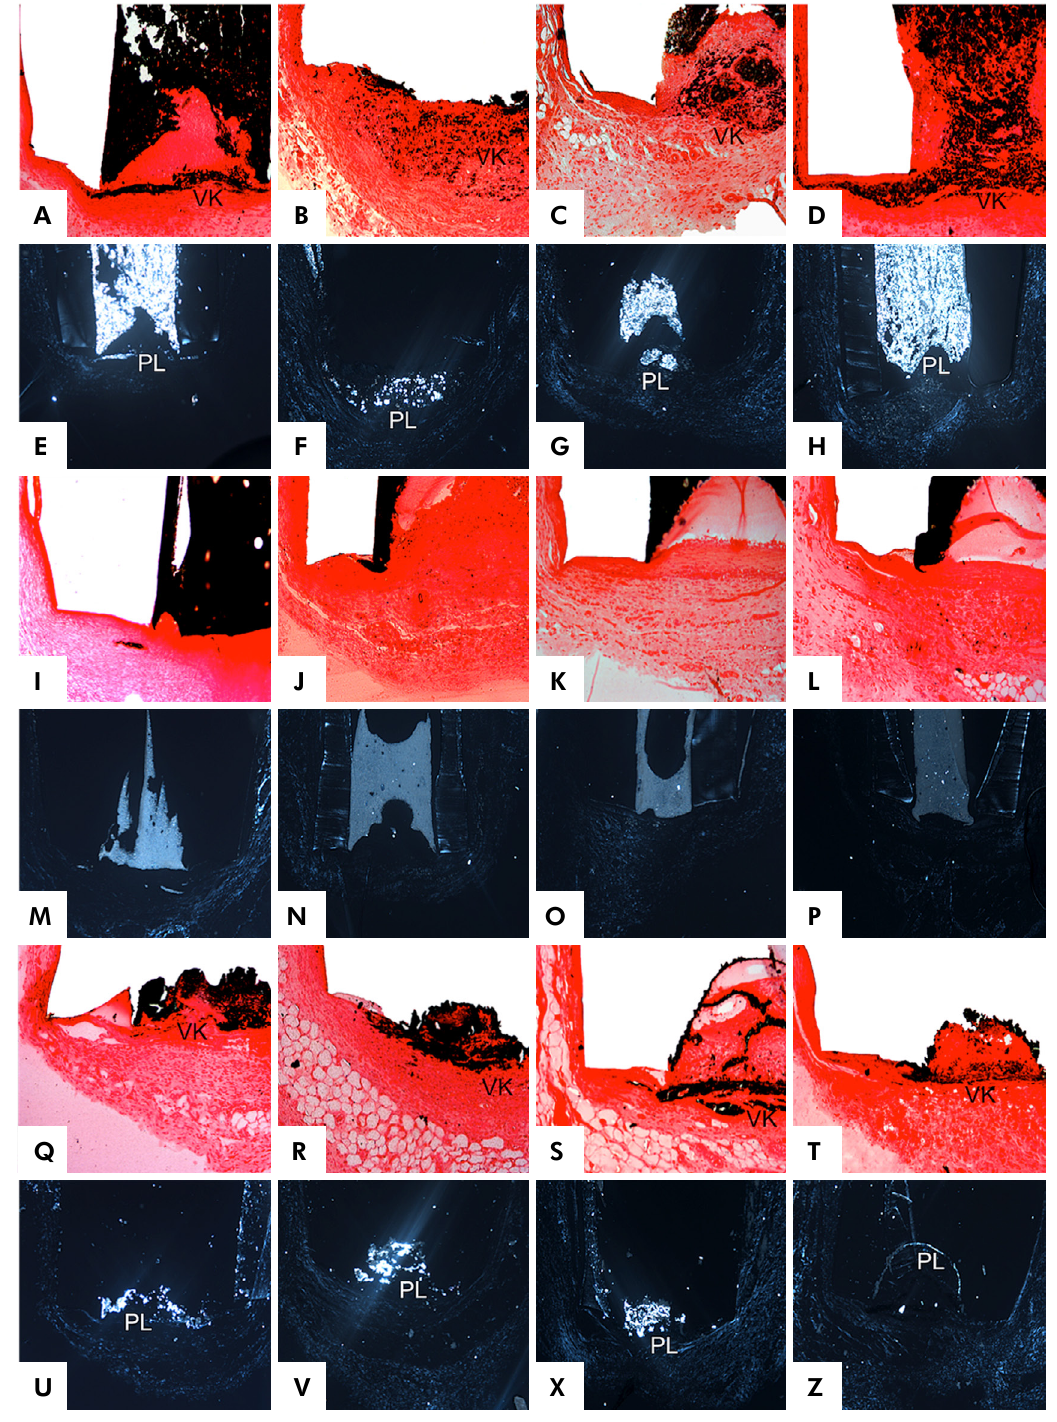
Figure 2. Biomineralization in the experimental groups. Sealapex: (A–D) the presence of dystrophic calcification on the tube opening (days 7, 15, 30, and 60; Von Kossa, 10 ×) and (E–H) the presence of birefringent structures under polarized light (days 7, 15, 30, and 60, polarized light 5 ×); Acroseal: (I–L) the absence of dystrophic calcification on the tube opening (days 7, 15, 30, and 60; Von Kossa, 10×) and (M–P) the absence of birefringent structures under polarized light (days 7, 15, 30, and 60; polarized light, 5 ×); and Smartpaste Bio: (Q–T) the presence of dystrophic calcification on the tube opening (days 7, 15, 30, and 60; Von Kossa, 10 ×) and (U–Z) the presence of birefringent structures under polarized light, slightly disappearing through the time periods (days 7, 15, 30, and 60; polarized light, 5